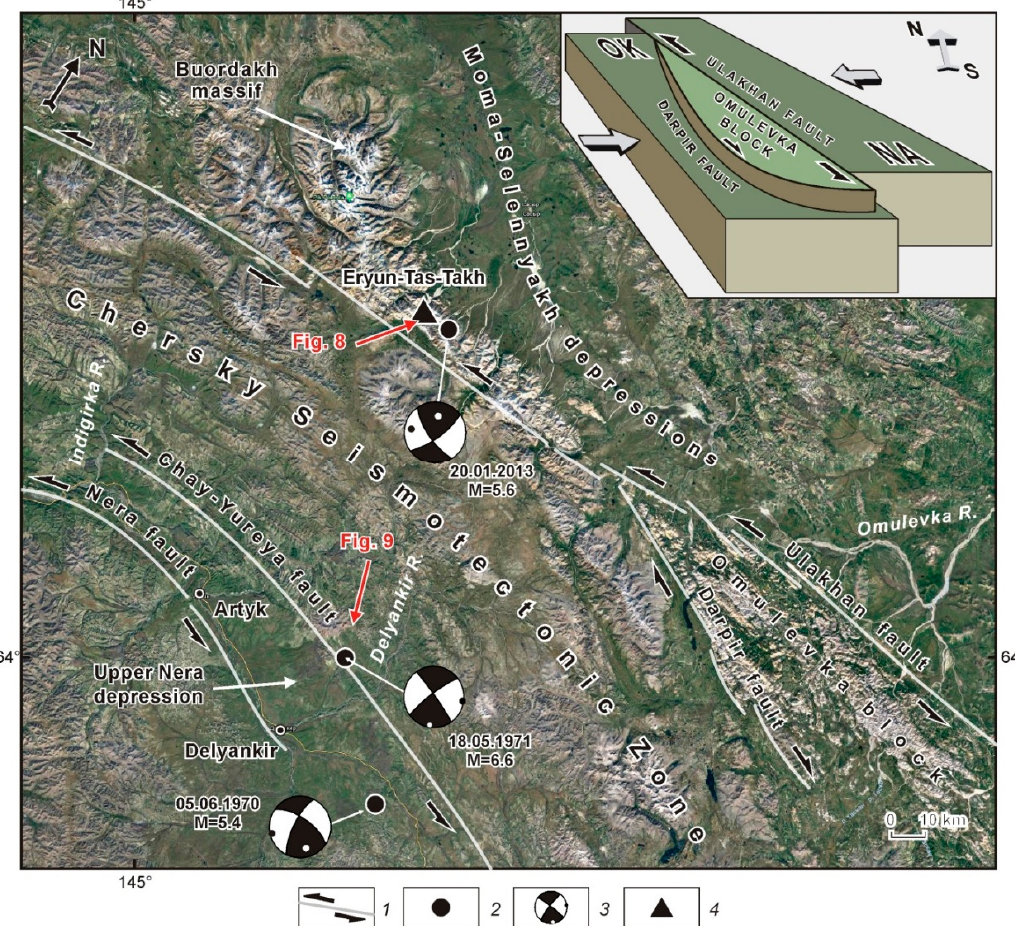
Figure 7. Structural dynamics of the Omulevka block. 1—active strike-slip fault; 2—earthquake epicenter; 3—focal mechanisms, dates and magnitudes of earthquakes (lower hemisphere; the principal stress axes of compression and extension are marked by black and white dots,